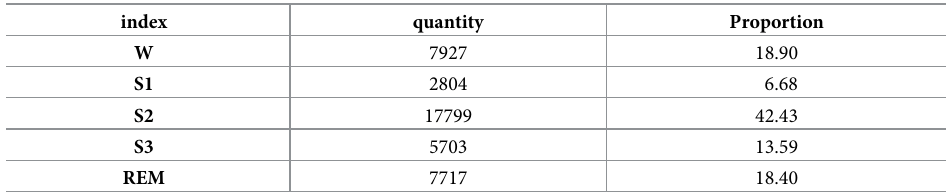
Table 1. Sleep -EDF sleep